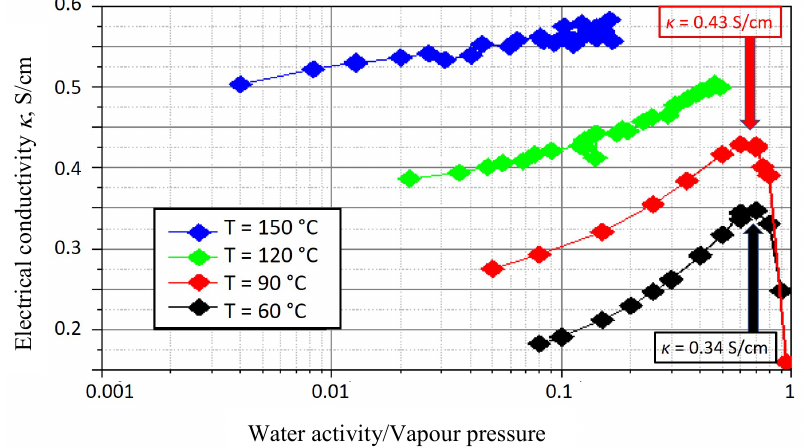
Fig. 4. Electrical conductivity κ of phosphoric acid solutions vs . water activity/vapour partial pressures at four different temperatures: 150 °C (blue), 120 °C (green), 90 °C (red), and 60 °C (black). The maxima of κ can be observed at a water content higher than 30 wt%, which is in good agreement with the results of Melchior et al . [11] and the compilation of Korte [6]. In the case of the higher temperatures, i.e. at 120 °C and 150 °C, the performances of the climate chamber were insufficient to reach the requested high water vapor pressure to detect the expected